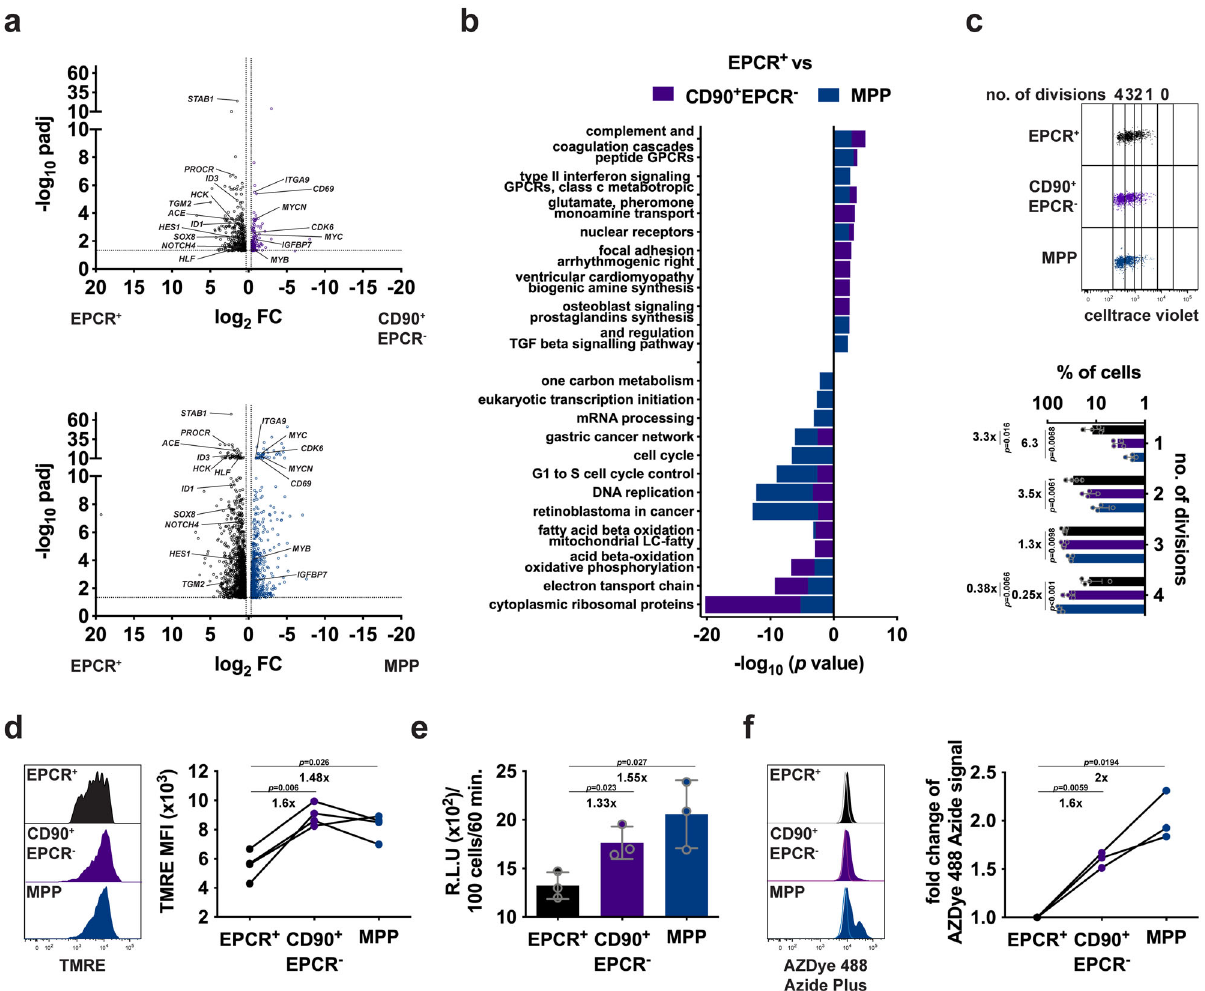
Fig. 5 De fi ning the molecular features of EPCR + HSCs. a Volcano plot representation of the RNA-seq data derived from 5 EPCR + vs 4 CD90 + EPCR − (top) or vs 5 MPP samples (bottom). b Wikipathways analysis identi fi ed signi fi cant enriched functional categories (FDR < 0.05 with P -values